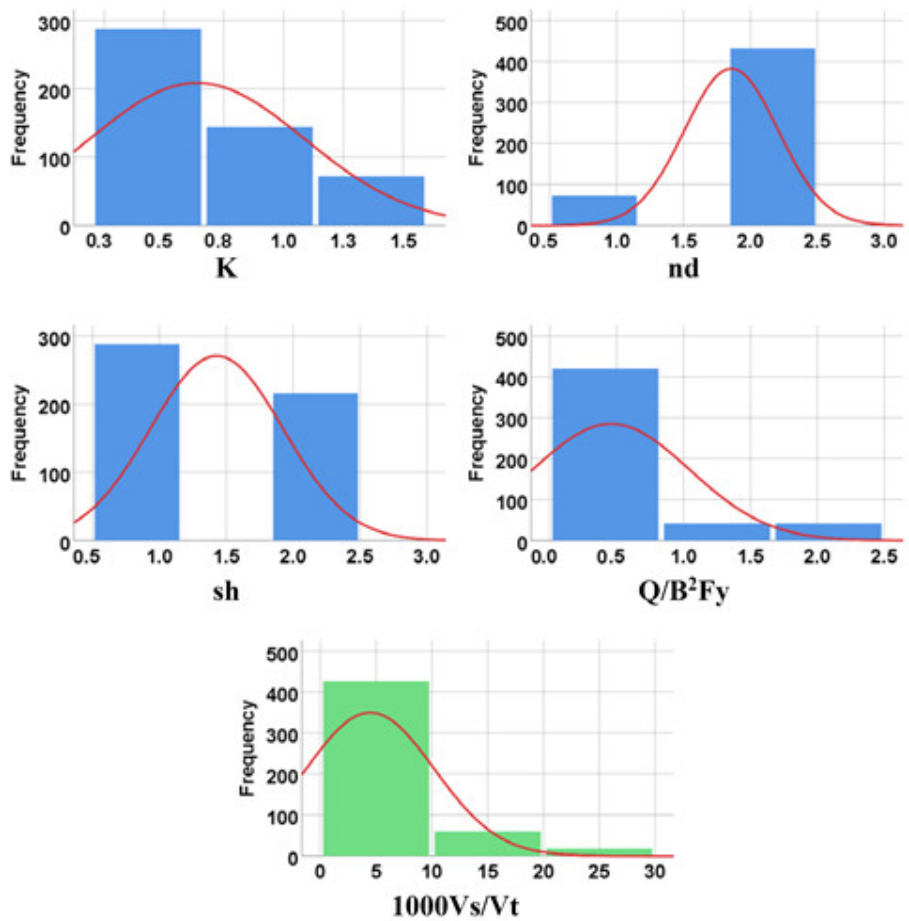
Figure 3. Distribution histograms for inputs (in blue) and outputs (in green).